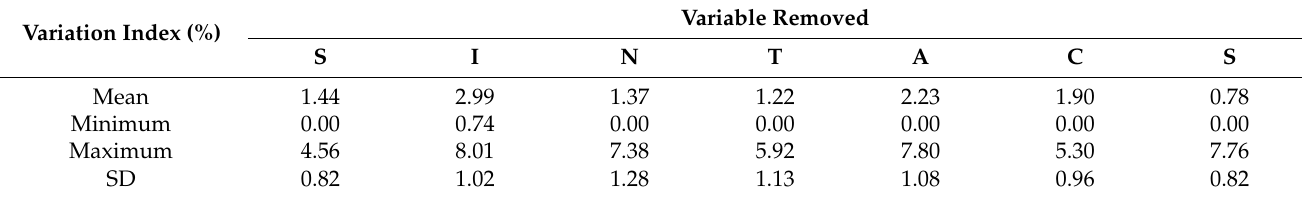
Table 3. Statistical summary of the SINTACS map removal sensitivity analysis.